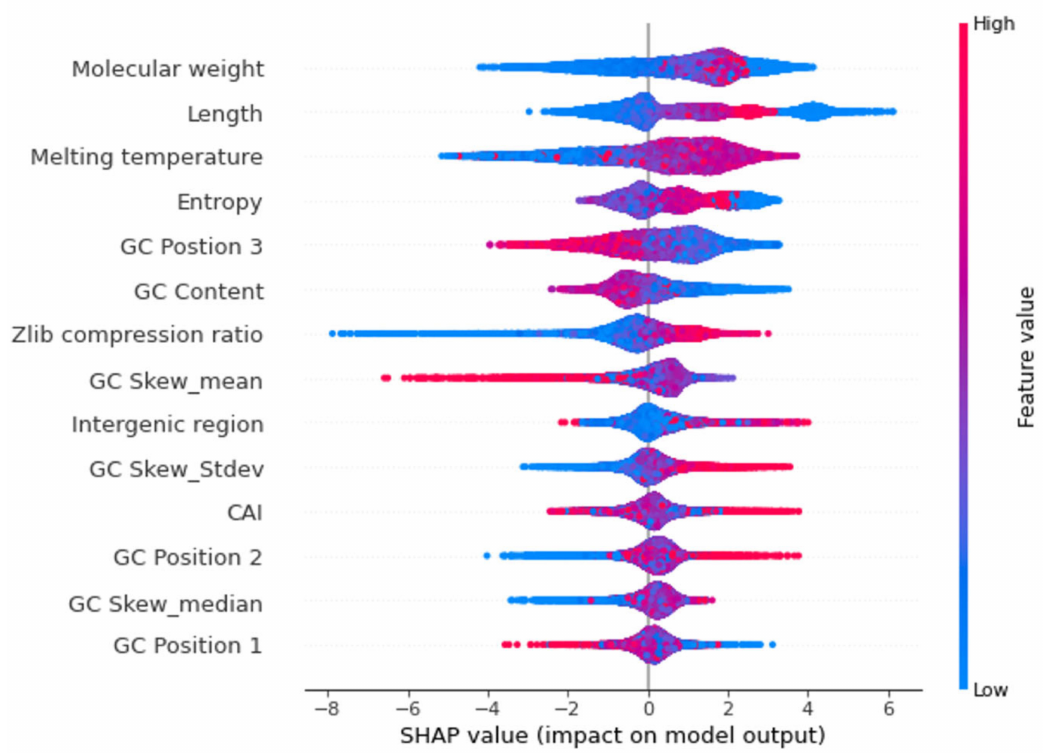
Figure 7. Beeswarm plot for the 14 features that contribute to nucleotide model. Each dot indicates one value, and they pile up in each row to show density. The red dots represent higher feature value while the blue dots represent lower feature value. The positive side indicates high confidence genes and while the negative side indicates low confidence